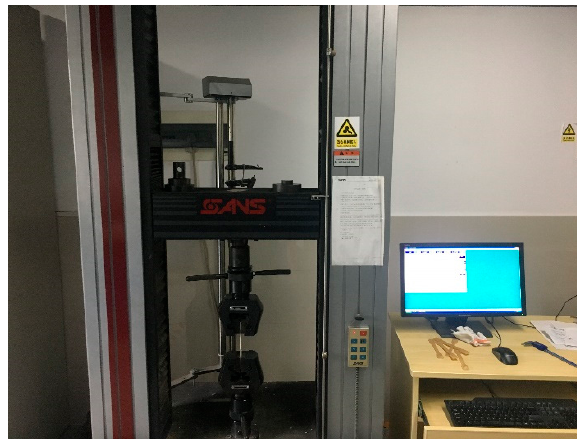
Figure 3. Universal testing machine.